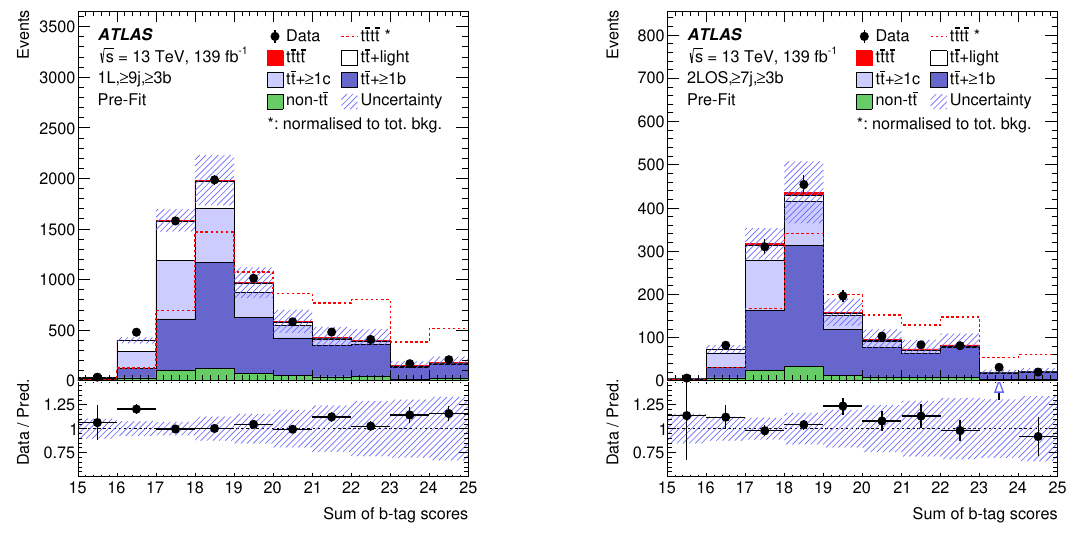
Figure 5 . Pre-fit comparison between data and prediction for the distributions of the sum of the pseudo-continuous b -tagging score over the six jets with the highest score in the event for the 1L channel (left) and the 2LOS channel (right) in the regions with ≥ 3 b -jets and ≥ 9 (7) jets in the 1L (2LOS) channel. The t ¯ t +jets background is corrected using data. The band includes the total uncertainty of the pre-fit computation. The dashed red line shows the signal distribution normalised to the background yield. The ratio of the data to the total pre-fit expectation is shown in the lower panel. The last bin contains overflow